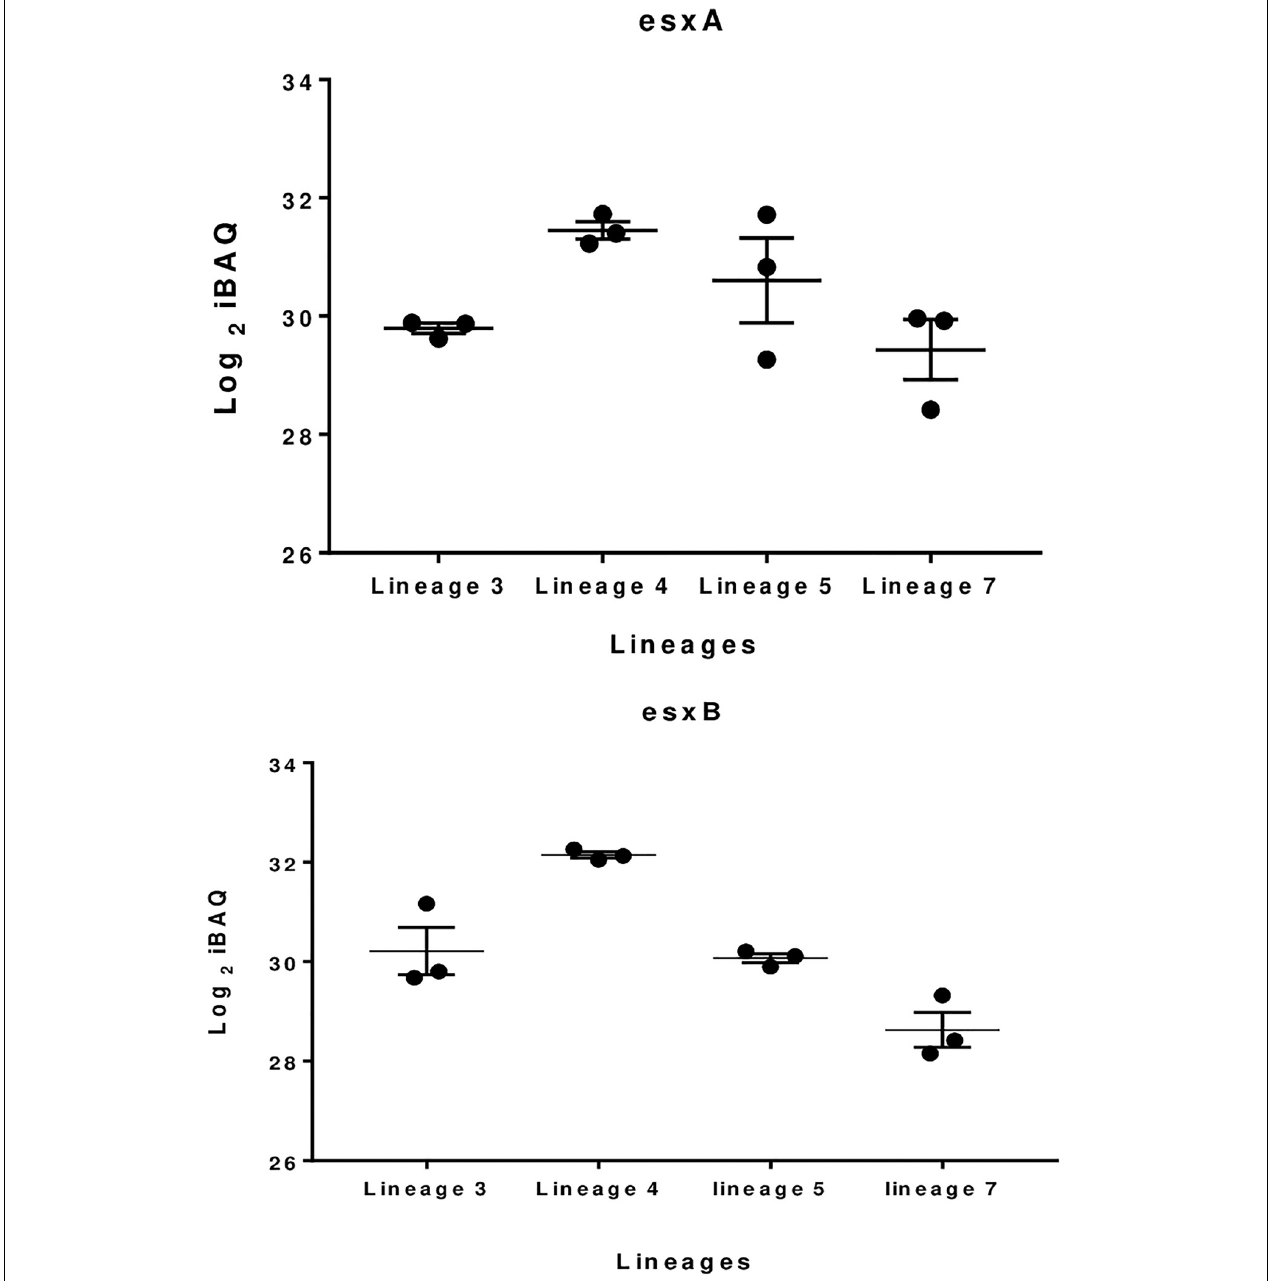
FIGURE 4 | Boxplot showing difference in EsxA and EsxB proteins abundance in the various MTBC lineages.